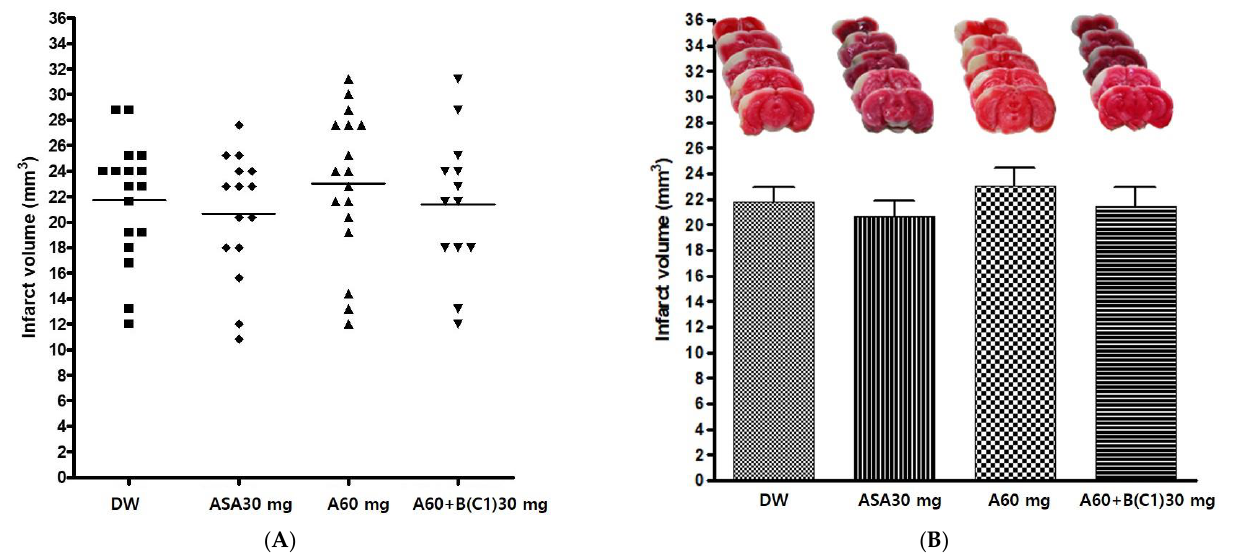
Figure 2. Effects of experimental drug A60+B(C1) 30 mg/kg on ischemic brain injury after permanent middle cerebral artery occlusion (pMCAO). Infarct volume was measured 24 h after pMCAO. DW and all drugs were administered just before pMCAO. ( A ) Individual infarct volume values for each group (n = 13 – 17 mice in each group). ( B Upper ) Representative photographs of infarcted brain slices from DW- and drug-treated mice. ( B Lower ) There was no significant difference in infarct volume among groups. DW, distilled water; ASA, Aspirin ® ; A, Ethanol extract of Coptidis Rhizoma, Phellodendri Cortex, Scutellariae Radix, Gardeniae Fructus, and Rhei Rhizoma; B(C1), Ethanol extract of 2018 Chinese Salviae miltiorrhizae Radix and Notoginseng Radix. Data represent means ± standard deviation.